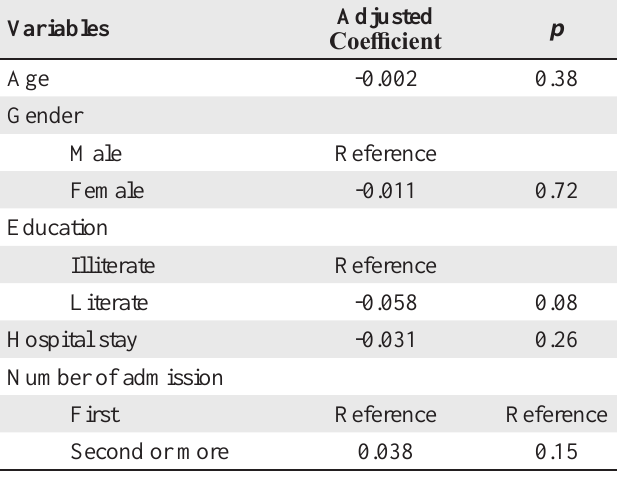
Table 2 : Adjusted coefficient of regression